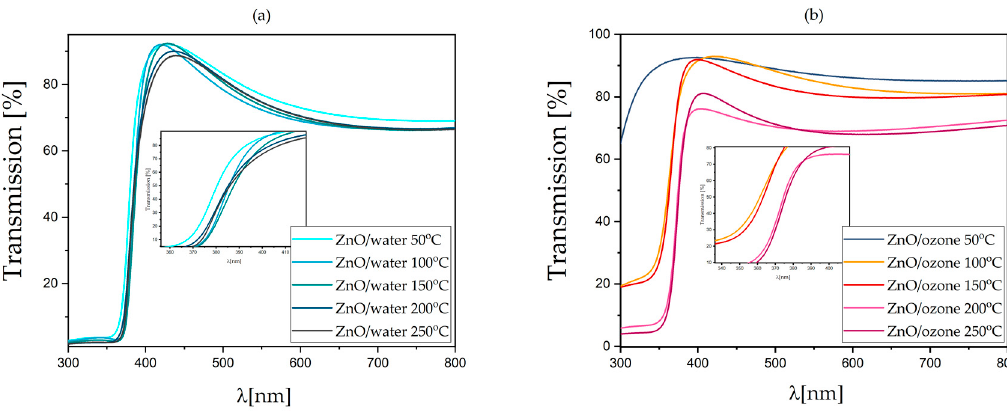
Figure 6. The data of optical transmission spectra for two types of the ZnO samples: the water-based samples ( a ) and the ozone-based samples ( b ). Insets shows enlarged displacement of relevant lines.